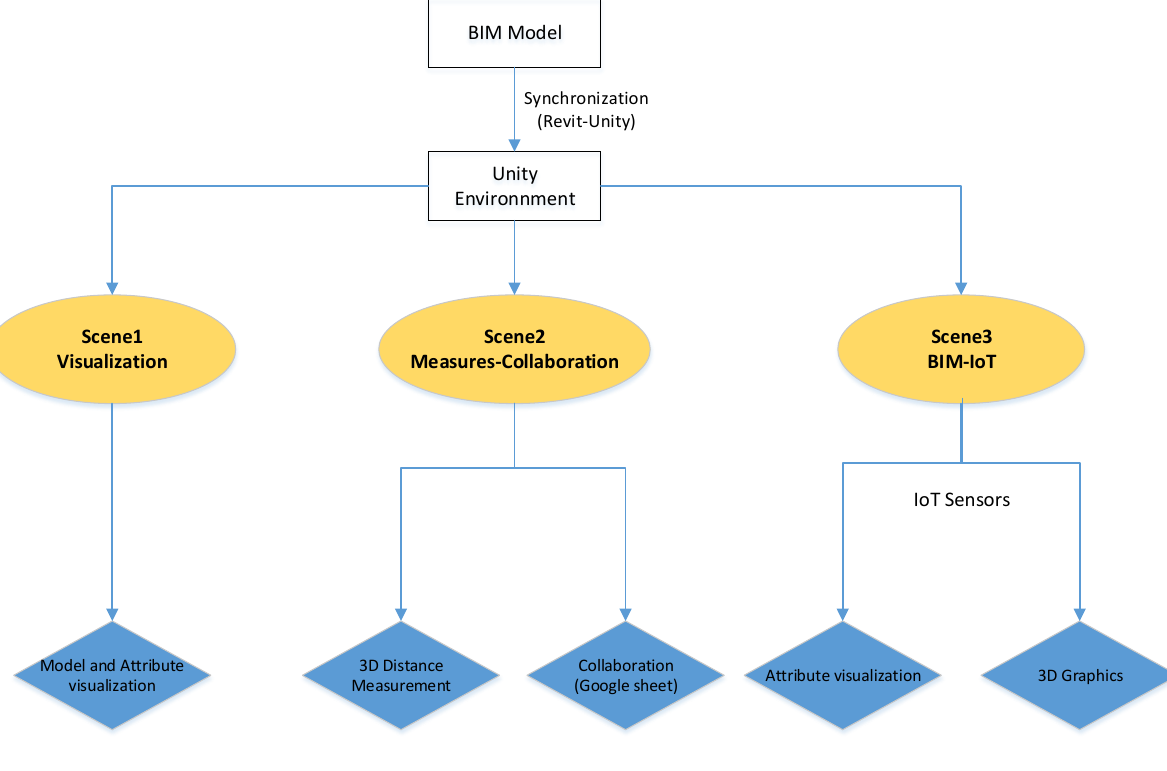
Figure 2. The architecture of the application